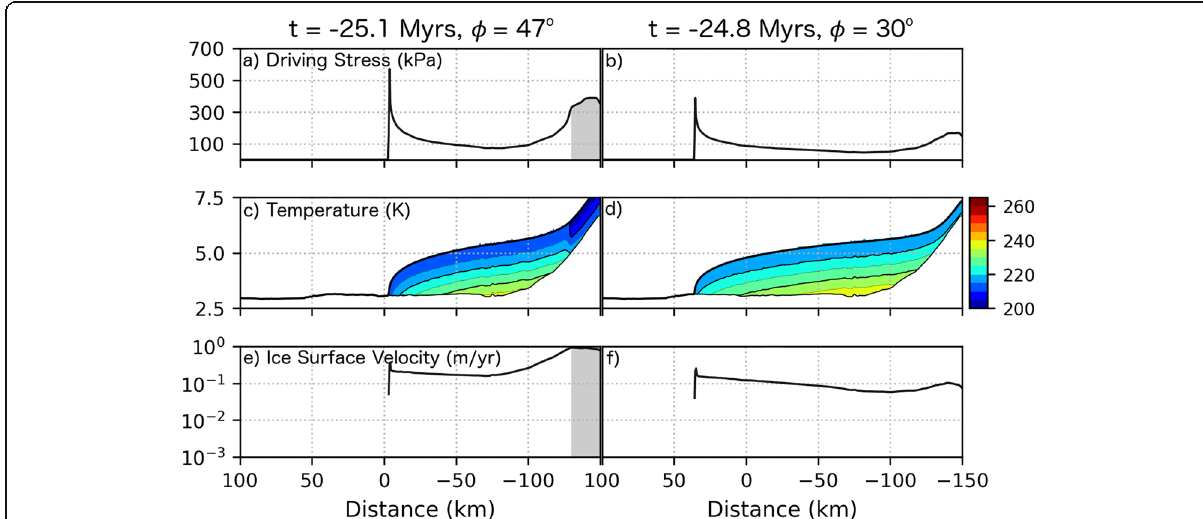
Fig. 11 Simulation results depicting the ice deposit properties and flow velocities at high (47 ° ) and low (30 ° ) obliquities during ice sheet advance. Panels ( a , c , and e give the basal driving stress, temperature, and ice surface velocity, respectively, at high obliquity ( − 25.1 Myr) as shown in Fig. 6 a and b. Panels b , c , and f give the same set of properties at low obliquity ( − 24.8